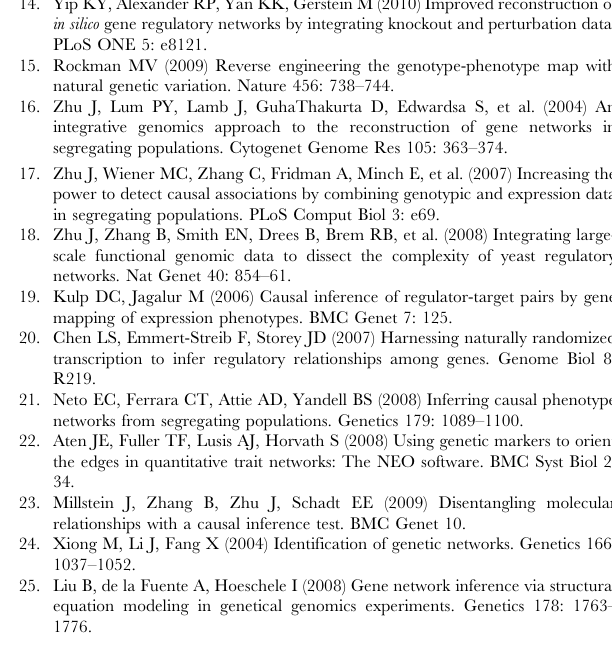
Figure S4 The network of 39 human genes inferred from gene expression and eQTL data with the SML algorithm. The 39 genes related to the immune system were chosen from [45] to have a reliable eQTL per gene. The SML algorithm was run with stability selection and edges were detected at an FDR v 0 : 3 . See Table S1 for the IDs and description of 39 genes. IGH in this figure corresponds to gene ID ENSG00000211897. A a edge stands for inhibitory effect and a ? edge stands for activating effect. (TIF) Table S1 Thirty nine immune-related human genes used to infer a network. (XLSX) Table S2 Edges of the gene network in Figure 6 inferred with the SML algorithm and edges detected with AL and QDG algorithms.